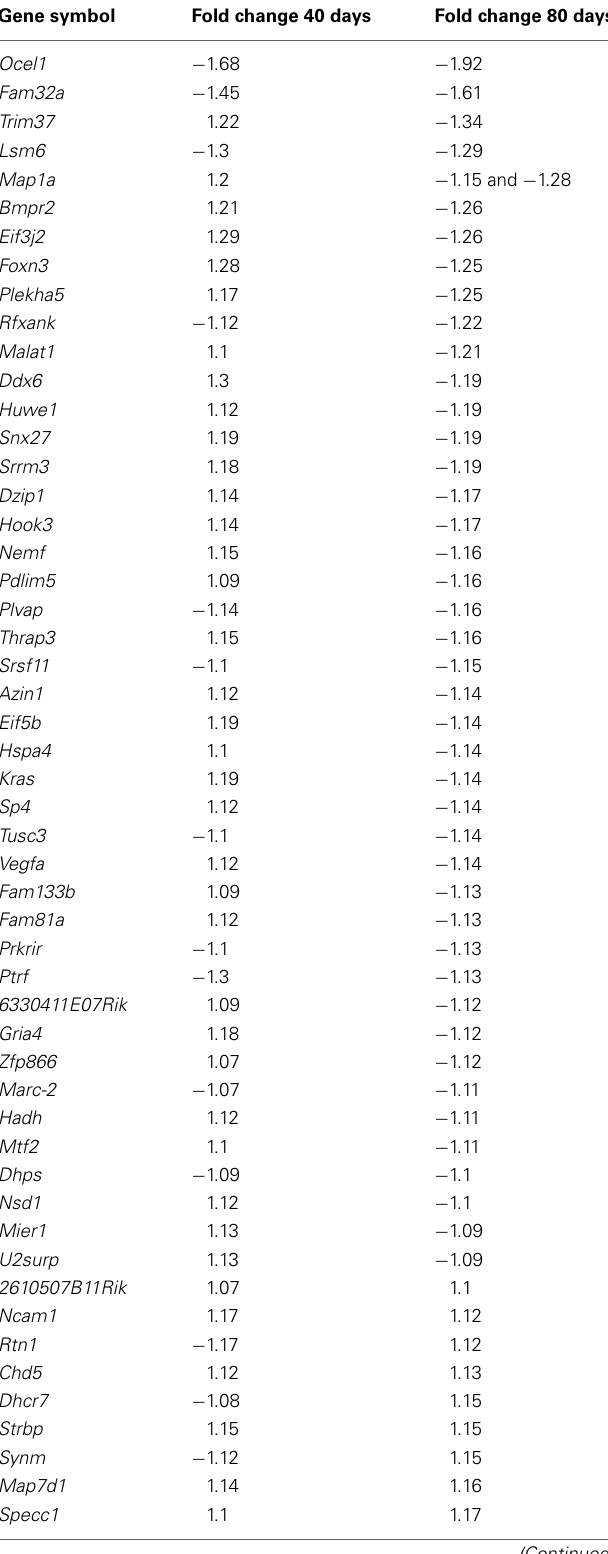
Table 2 | Differentially expressed genes common to both gene lists of 40 and 80 days old pre-symptomatic SOD1 G93A and wild-type